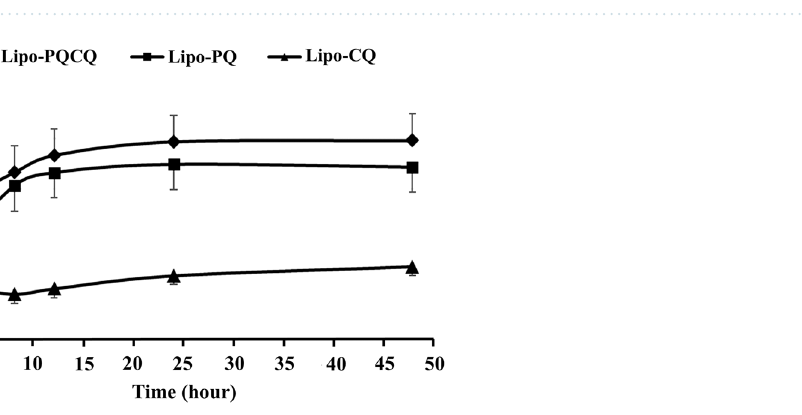
liposomes (Lipo-PQ), chloroquine-loaded liposomes (Lipo-CQ), and liposomes loaded with both primaquine and chloroquine (Lipo-PQCQ) in CDCL 3 at 400 MHz.